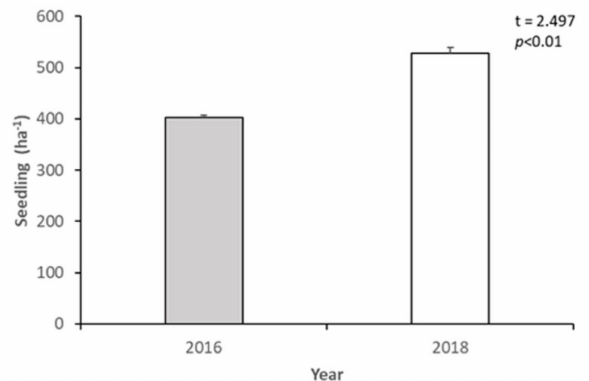
Figure 4. Short-term dynamics of Abies nephrolepis seedlings for two years (2016 and 2018). The population dynamics of the species based on the height class data were as follows ( p < 0.001; − 1 − 1 Figure 5): The number of seedings < 10 cm in height increased from 108 ha in 2016 to 201 ha in − 1 2018; seedings of 10–30 cm in height increased from 110 to 121 ha ; seedings of 30–50 cm in height − 1 − 1 increased from 46 to 99 ha ; seedings of 50–100 cm decreased from 61 to 50 ha ; and seedings of > 100 cm in height decreased from 77 to 57 ha − 1 . As there was a forest gap in 2018, which was not there in 2016, the number of seedlings < 50 cm in height was higher in 2018, but seedlings > 50 cm decreased due to a failure of